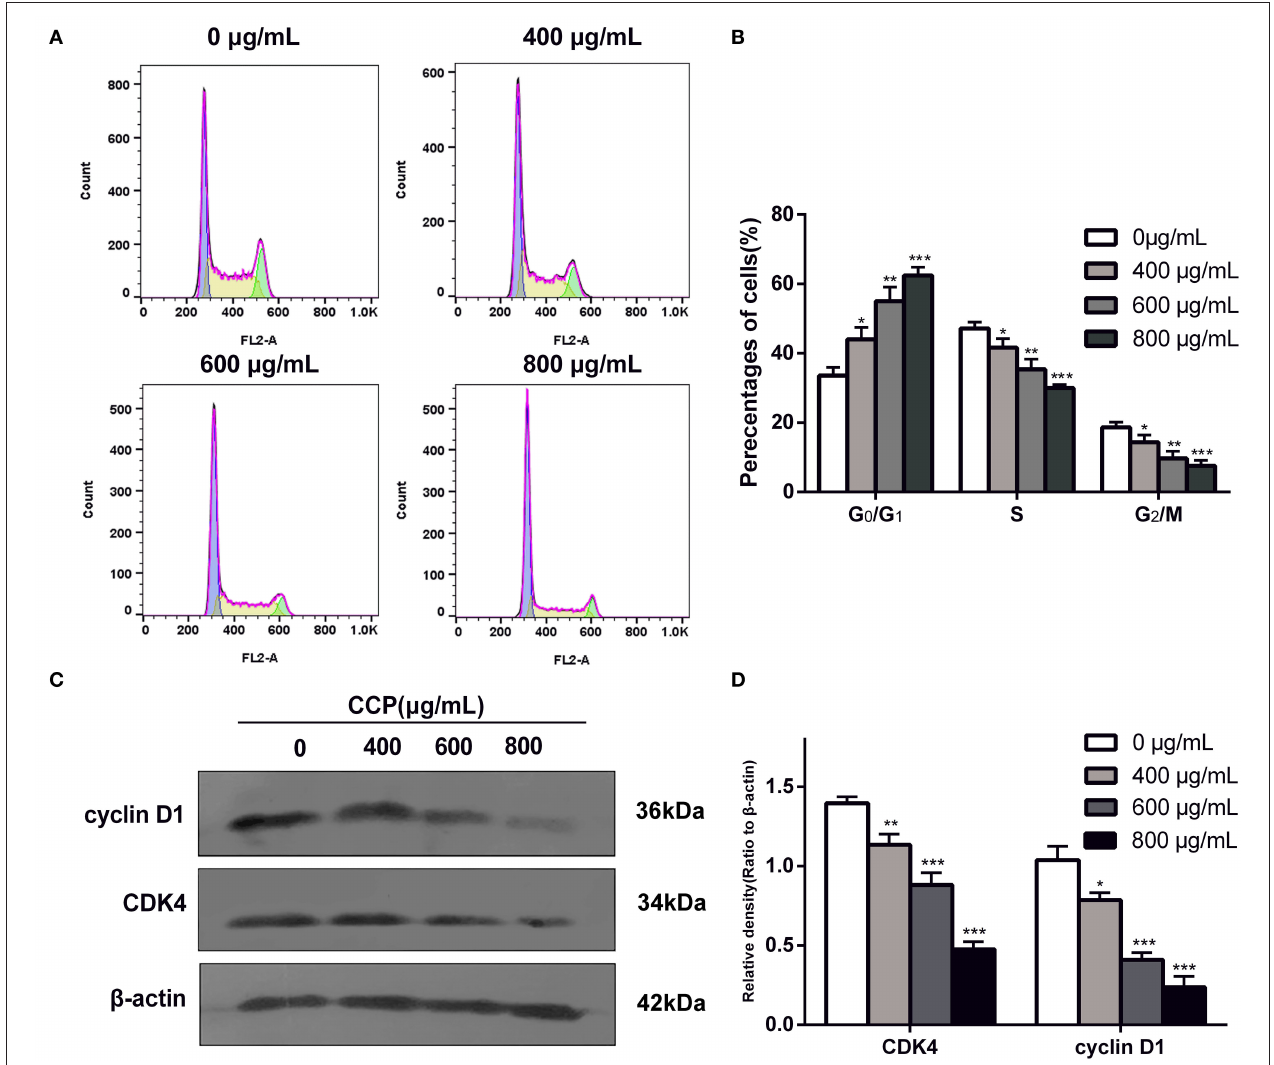
FIGURE 6 | Distribution (A) and proportions (B) of treated cell in various phases of the cell cycle. The expressions levels (C) and quantitative analysis (D) of cyclin D1 and CDK4. * P < 0.05, ** P < 0.01 and *** P < 0.001 vs. control group.